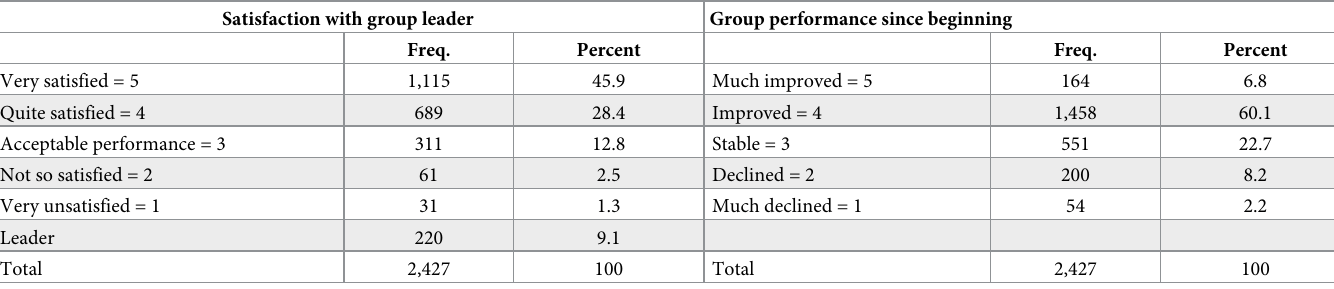
Table 4. Group leader satisfaction and group performance since the beginning.